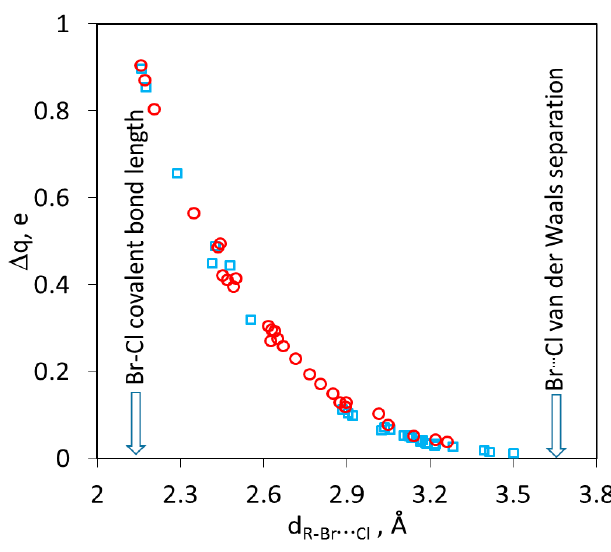
Figure 7. Relation between interatomic Br…Cl distances and amount of charge transfer in the R–Br·Cl − complexes calculated in vacuum ( ○ ) or dichloromethane ( □ ).